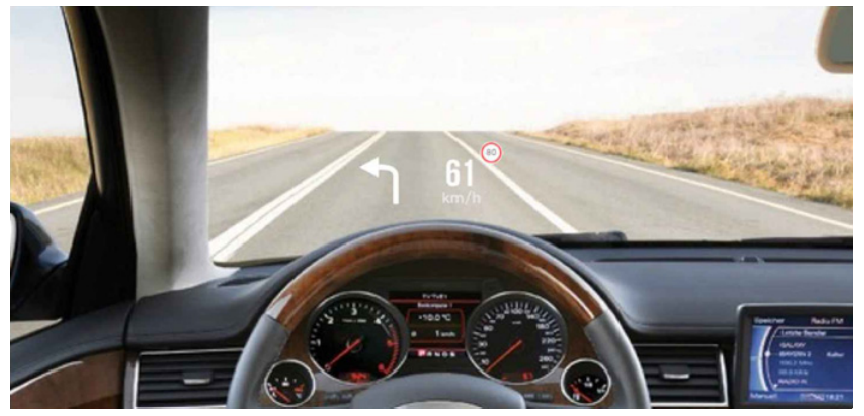
Figure 4. HUD display interface design rendering.